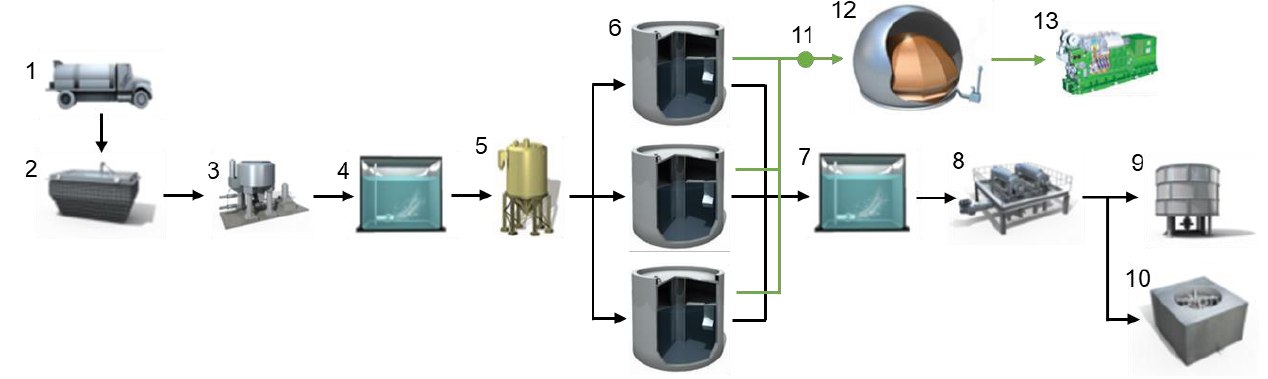
Figure 1. The schematic diagram of the system. 1, FW transportation; 2, FW storage tank; 3, pretreatment system to remove indigestible parts and to add some water; 4, storage tank; 5, pre-acidification tank; 6, triplicate digesters; 7, digestate storage tank; 8, solid-liquid separator; 9, composter; 10, wastewater treatment system; 11, gas flowmeter; 12, biogas storage tank; 13, biogas purification and utilization system. Black and green arrows indicate mass and gas flows, respectively.